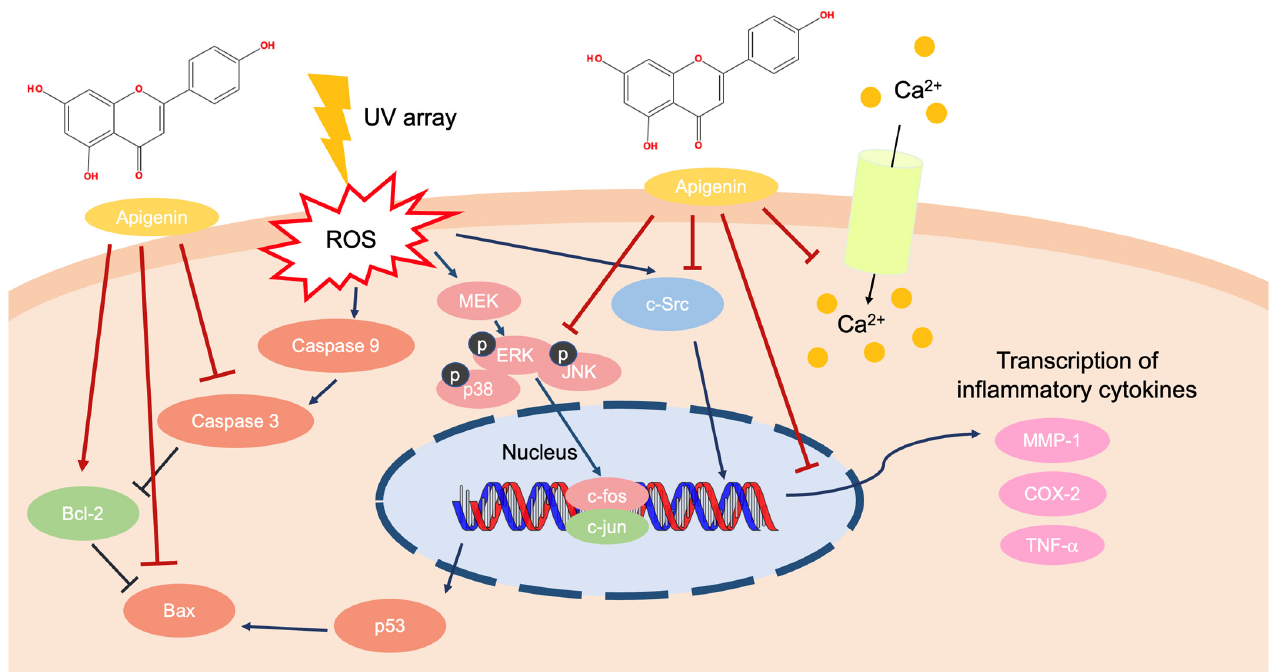
Figure 3. The molecular interactions of apigenin due to UV